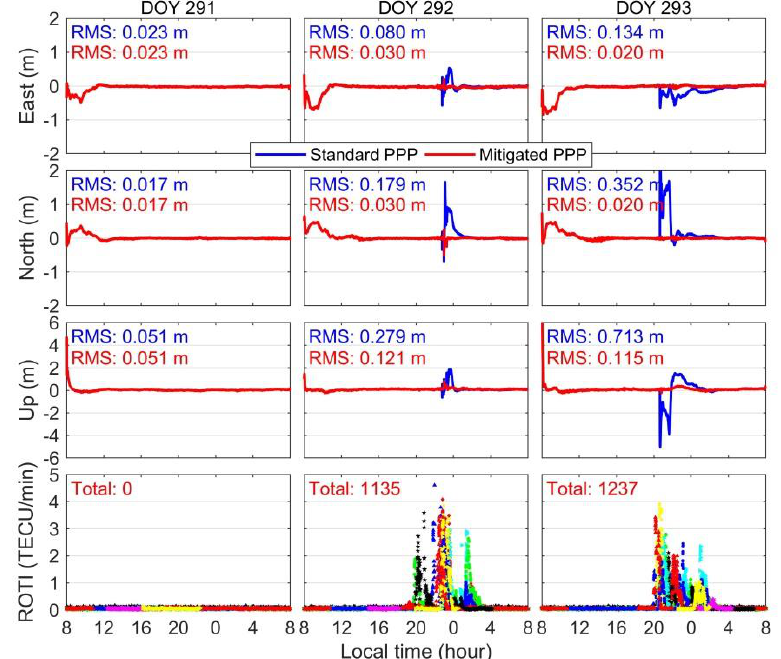
Figure 10. BDS positioning results of standard and mitigated PPP solutions under different ionospheric environments on 18, 19, and 20 October 2015.